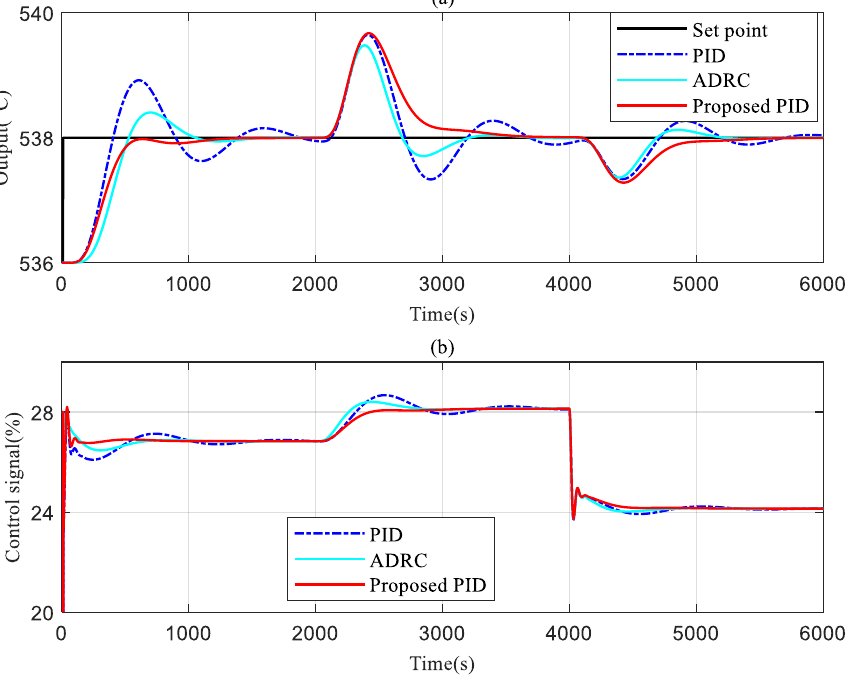
Figure 7. Control performance under an operating condition of 50% load (( a ): outputs, ( b ): control signals). Table 2. IAE of different controllers under different operating conditions.